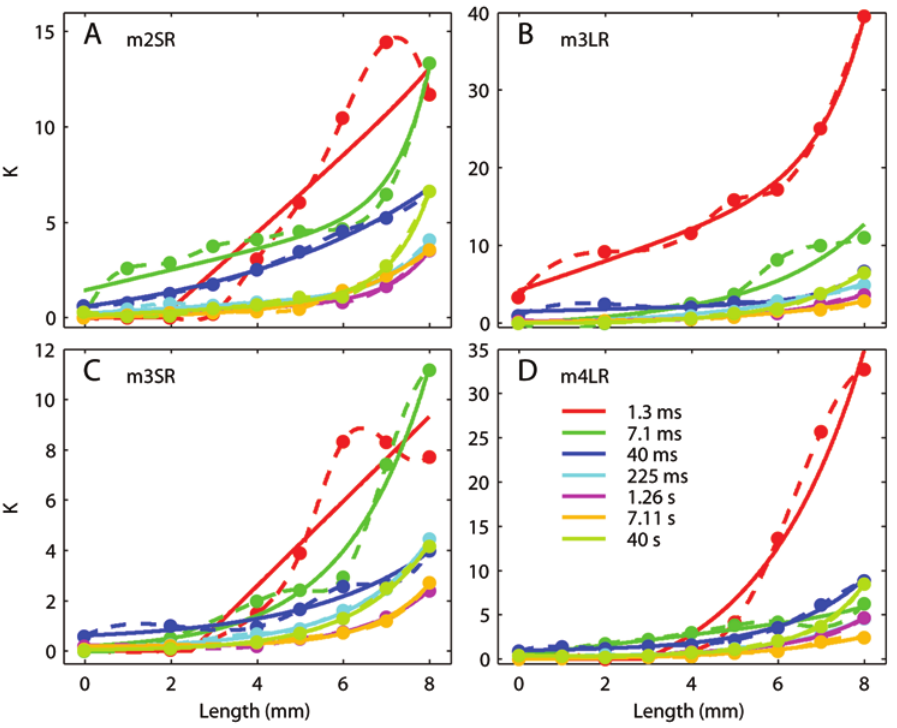
Figure 7. Parameters for the AQLV model. Each panel shows the parameters for a different muscle, as a function of length at the end of the step. The parameter values (dots) have been computed from the optimized QLV parameters, and the length shown is the muscle length after the end of the step. To estimate the values for an arbitrary length we then either used a cubic spline interpolation (dotted lines, used in Fig. 6), or a four- parameter nonlinear fit (solid lines, used in Fig. 8).